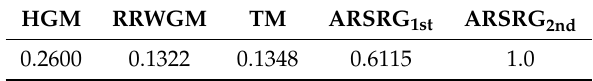
Table 4. Quantitative comparison, using the MRR measure, among the HGM [15], RRWGM [33], and TM [34] algorithms and the ARSRG matching on the dataset in